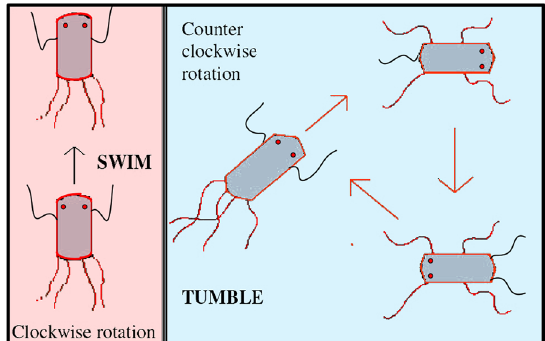
Fig. 7 The bacterial